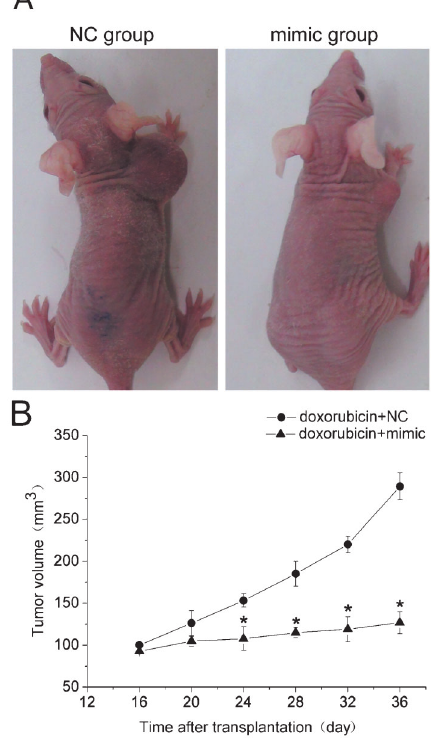
Figure 5. miR-30c regulated doxorubicin (ADR) resistance in vivo . The experiment was carried out using 6-week-old nude mice implanted subcutaneously ( sc ) with 5 6 10 5 MCF-7/ADR cells weekly. The treatments were administered as indicated in Material and Methods. A , The nude mice bearing tumors at 36 days after the sc transplantation are shown. NC: negative control. B , Curves of tumor growth in the nude xenografts of the MCF-7/ ADR cells (*P , 0.05, Student t